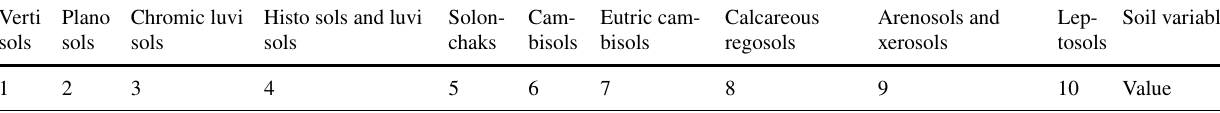
Table 4 The soil variable and scoring of this variable Verti Plano Chromic luvi sols sols sols